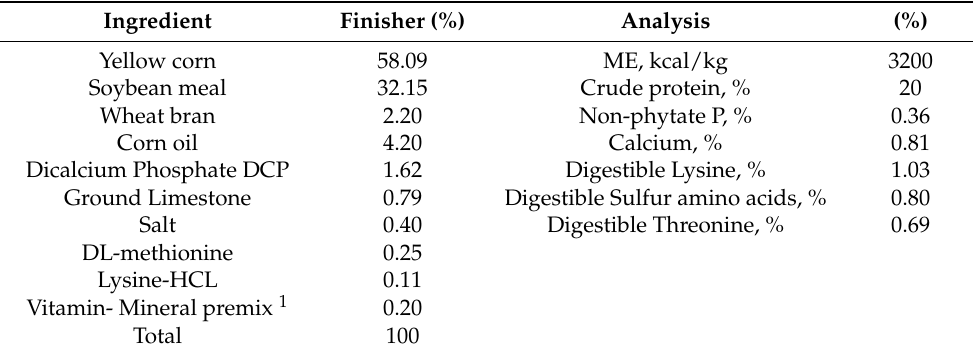
Table 1. Ingredients (on fed basis) and calculated nutrients of broilers basal finisher diet. Ingredient Finisher (%) Analysis (%) Yellow corn